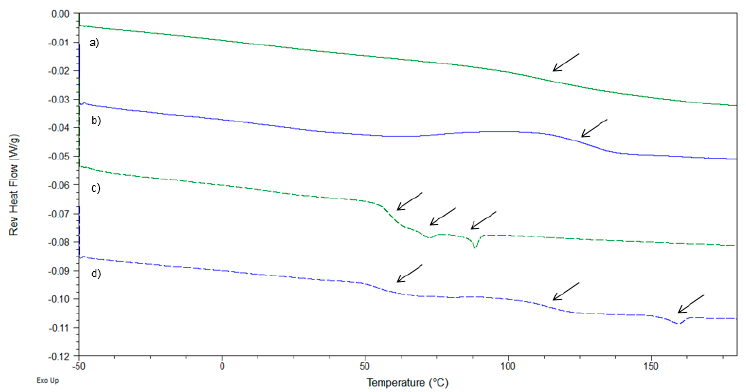
Figure 5. Reverse heat flow signals of ITR/PK30 40:60 ( w/w ) produced by ( a ) (green-solid line quench cooling) and ( b ) (blue-solid line) spray dryer. ITR/PK30 60:40 ( w / w ) produced by ( c ) (green-short dash) quench cooling and ( d ) (blue-short dash) spray dryer.